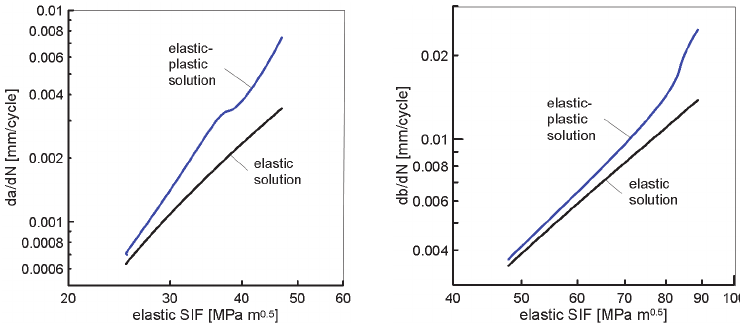
Figure 7: Crack growth rate comparison for elastic and elastic-plastic